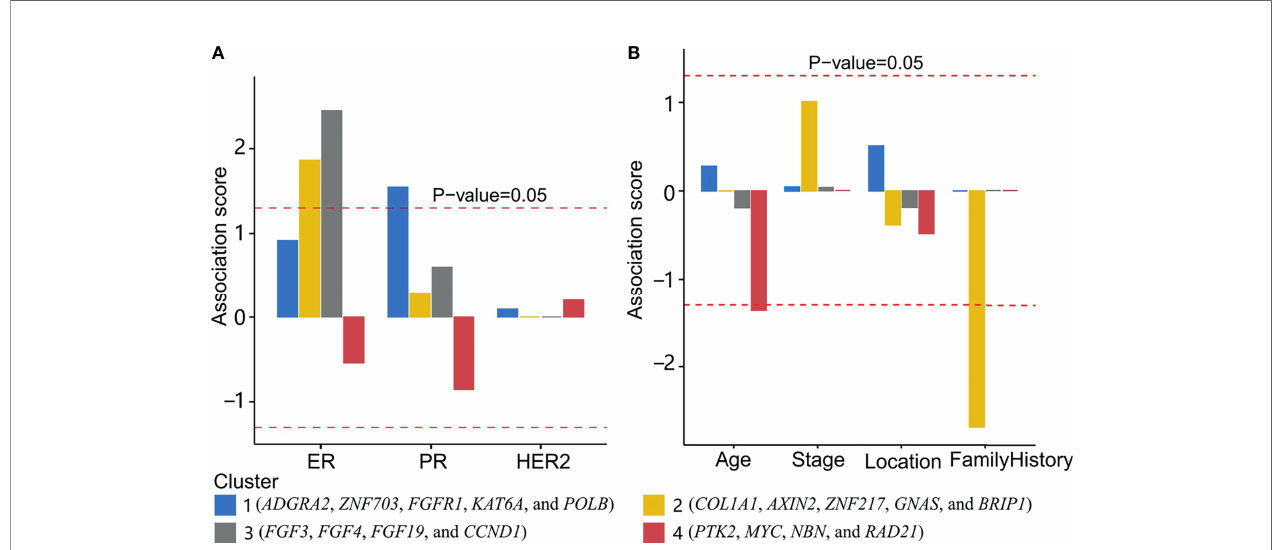
FIGURE 5 | Association between gene clusters and clinical characteristics. (A) The association between gene clusters and three biomarkers (ER, PR, and HER2 status). Above the upper and below the lower red dashed lines indicated a positive and negative association with P -value <0.05, respectively. (B) The association of clusters 1, 2, 3, and 4 with age, stage, location (primary or metastatic), and a family history of cancer was shown. Cluster 2 and cluster 4 were found negatively associated with a family history of cancer and age, respectively.